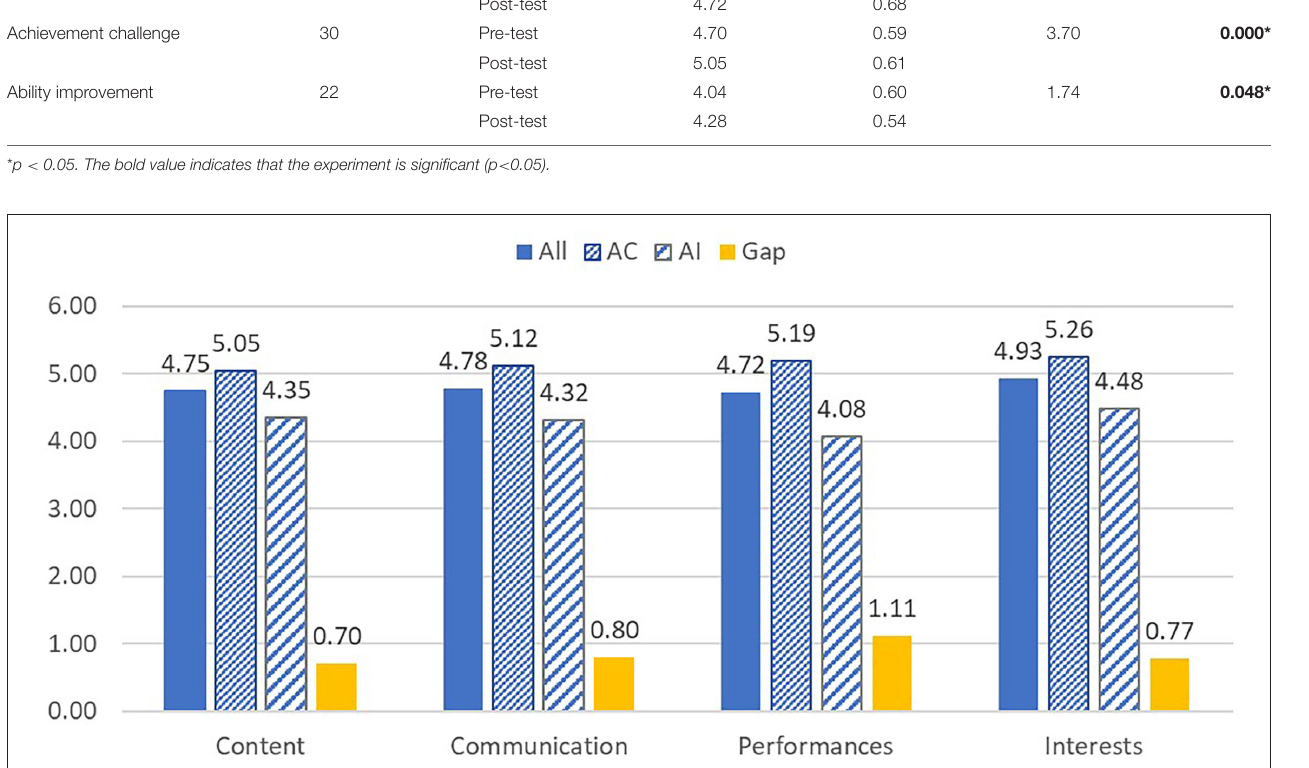
FIGURE 1 | Histogram of the average scores of four dimensions of students’ perceptions. All means all students. AC means the achievement of the challenge group. AI means the ability of improvement group. The gap means the difference of AC to